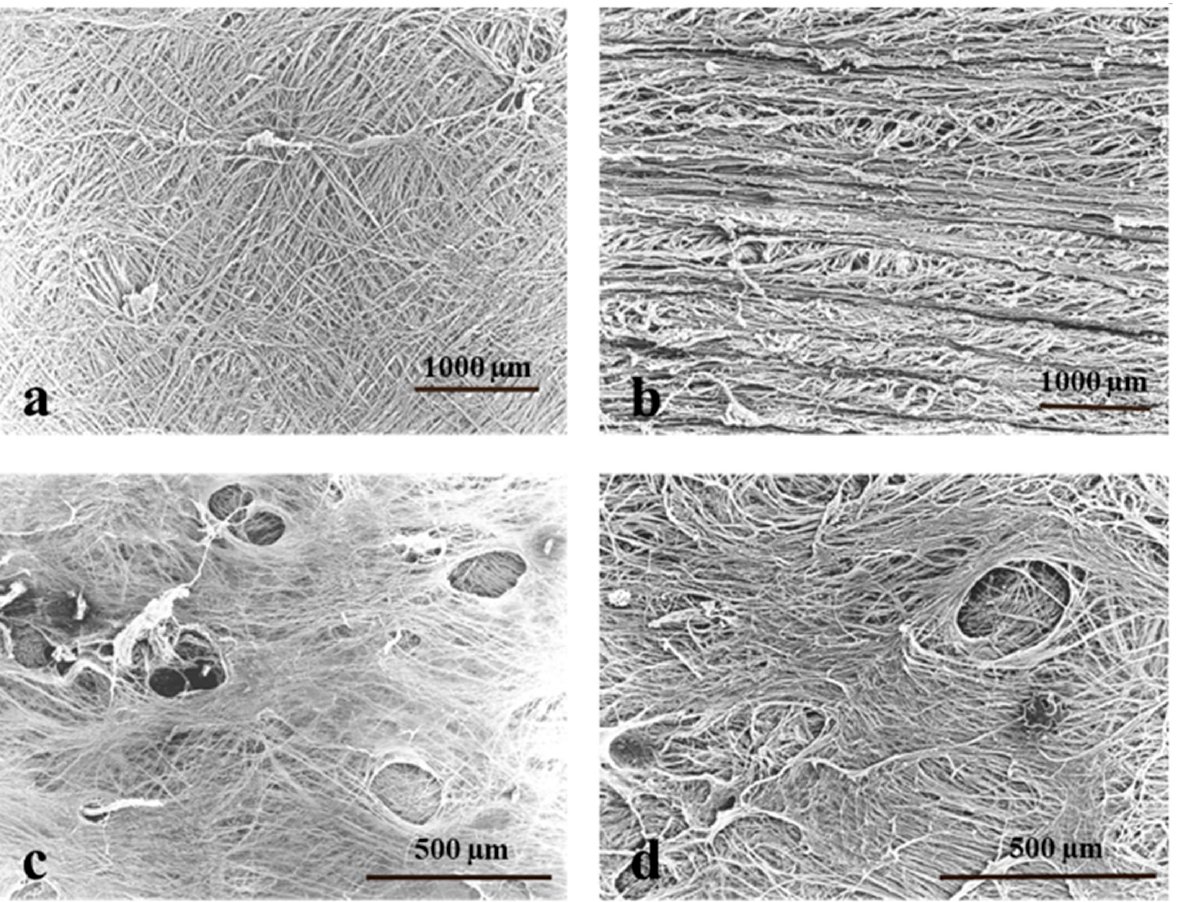
Figure 3. Structures of collagen fibers of Australian and Chinese sheep casings were observed using a scanning electron microscope. ( a , b ) External surface of sheep casings from Australia and China, respectively. ( c , d ) Internal surface of sheep casings from Australia and China, respectively.